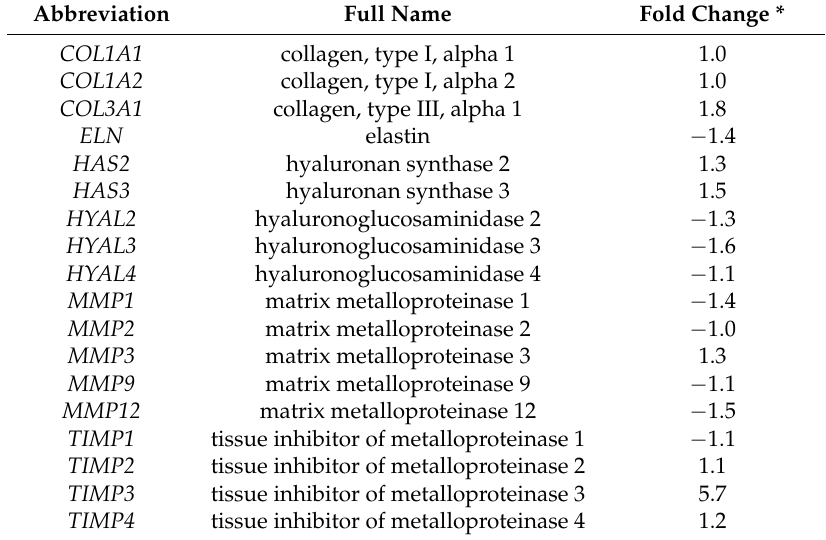
Table 2. Expression of extracellular matrix (ECM) genes in BCE-treated TIG113 cells.